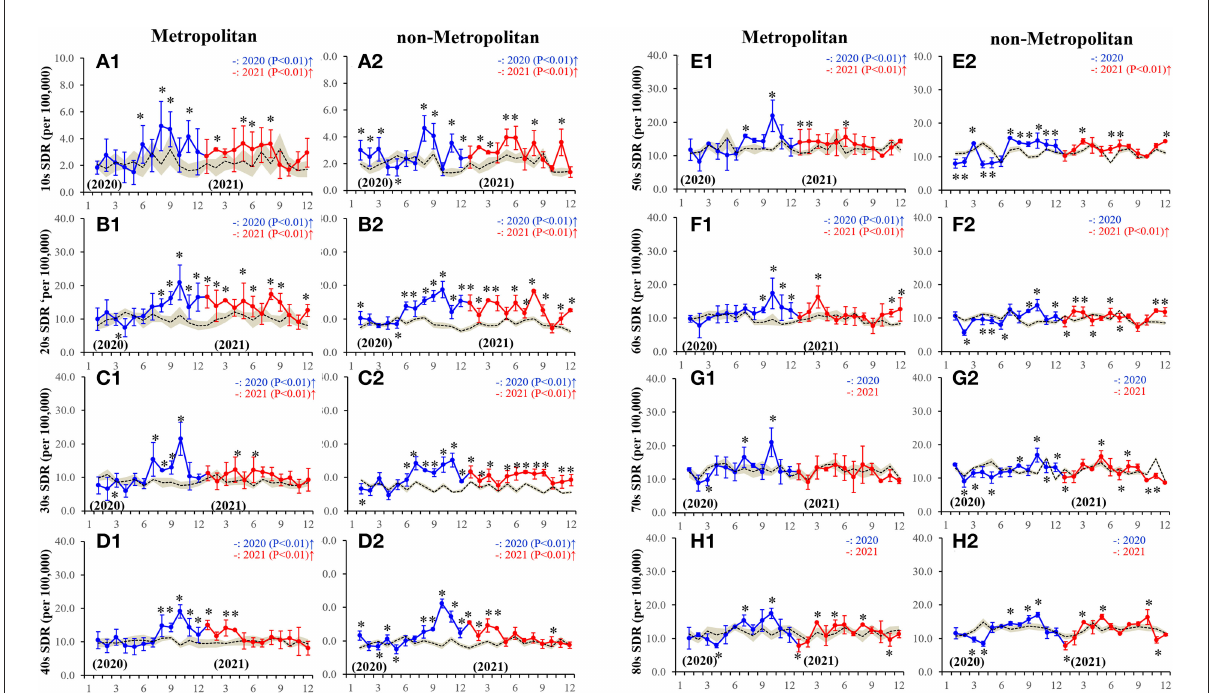
FIGURE2 Fluctuations of monthly females SDR disaggregated by regions, metropolitan (A1-H1) and non-metropolitan (A2-H2) regions, and ages, 10s (A1-A2) , 20s (B1-B2) , 30s (C1-C2) , 40s (D1-D2) , 50s (E1-E2) , 60s (F1-F2) , 70s (G1-G2) and 80s (H1-H2) , during the COVID-19 pandemic (2020–2021). Dotted, blue and red lines indicate the average predicted and observed SDRs in 2020 and 2021, respectively. Brown areas, blue and red bars indicate the 95% CI for predicted and observed SDR in 2020 and 2021, respectively. Ordinates indicate the standardized suicide mortality (per 100,000 people), and abscissas indicate the month. * p < 0.05, significant change of monthly SDR in comparison to predicted SDR using a linear mixed-effects model with Scheffe’s post-hoc test. ↑ and ↓ indicate significantly higher and lower observed annual SDR in comparison to predicted annual SDR,